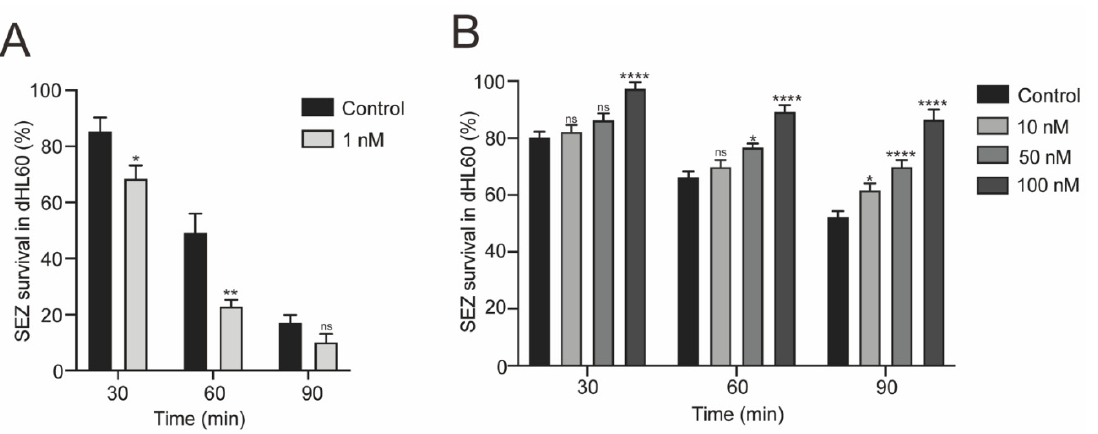
Figure 4. Appropriate concentration of Y27632 restored the dHL60 cells killing capability to SEZ. ( A ) The survival per- centage of wild-type SEZ in dHL60 cells at different time points. With 1 nM Y27632, dHL60 killed more bacteria within 60 min than control group ( n = 3, p values were calculated with Student’s t -test for each time point, * indicates p < 0.05; ** indicates p < 0.01; ns indicates no significant difference compare to control.). ( B ) In contrast, high concentration (10 nM, 50 nM and 100 nM) of Y27632 impaired dHL60 killing capability to wild-type SEZ. ( n = 3, p values were calculated with one- way ANOVA for each time point, * indicates p < 0.05; **** indicates p < 0.0001; ns indicates no significant difference com- pare to control).